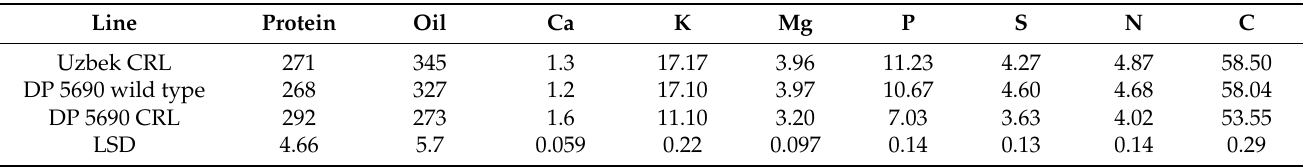
Table 3. Effects of leaf shape trait (curly leaf; CRL) on cottonseed protein and oil (g/kg); calcium (Ca), magnesium (Mg), potassium (K), phosphorus (P), sulfur (S) (mg/g); carbon (C), and nitrogen (N) (%). The experiment was conducted in 2015.